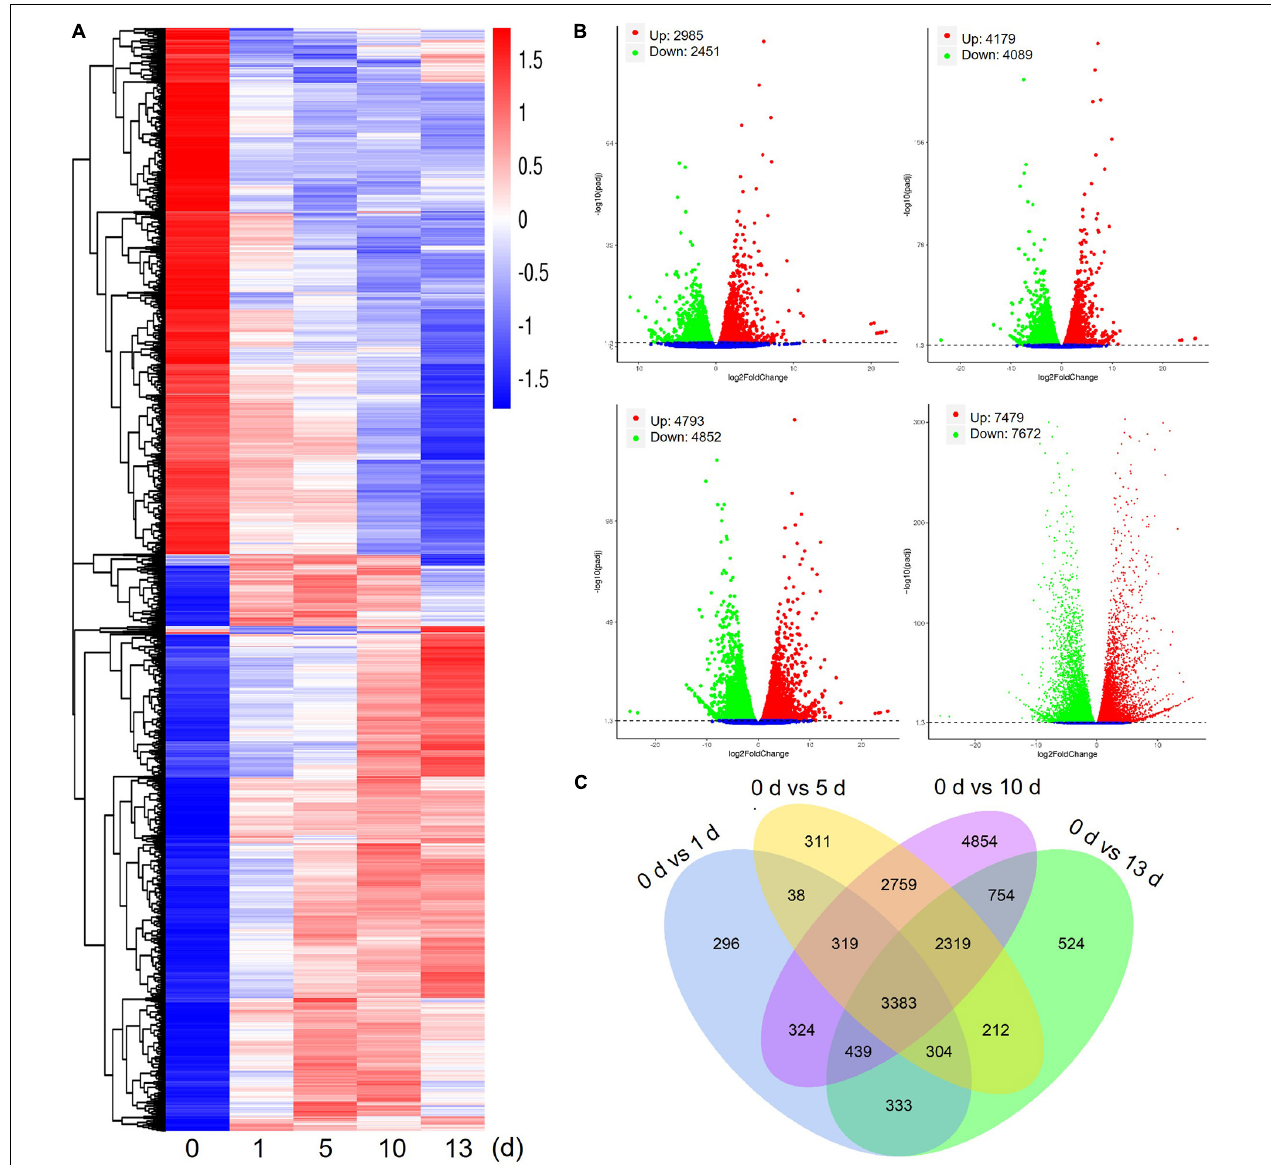
FIGURE 2 | Differentially expressed genes (DEGs) of date palm in response to high salinity from RNA-seq data. (A) Heatmap showed expression of increased or decreased trend of total DEGs for indicated time after salt stress treatment. The scaling of each gene to a mean of 0 and SD of 1.5. (B) Summary of significant upregulated and downregulated genes caused by high salinity for indicated time in date palm. (C) Venn diagram analysis showed a total of 17,169 DEGs in different conditions.